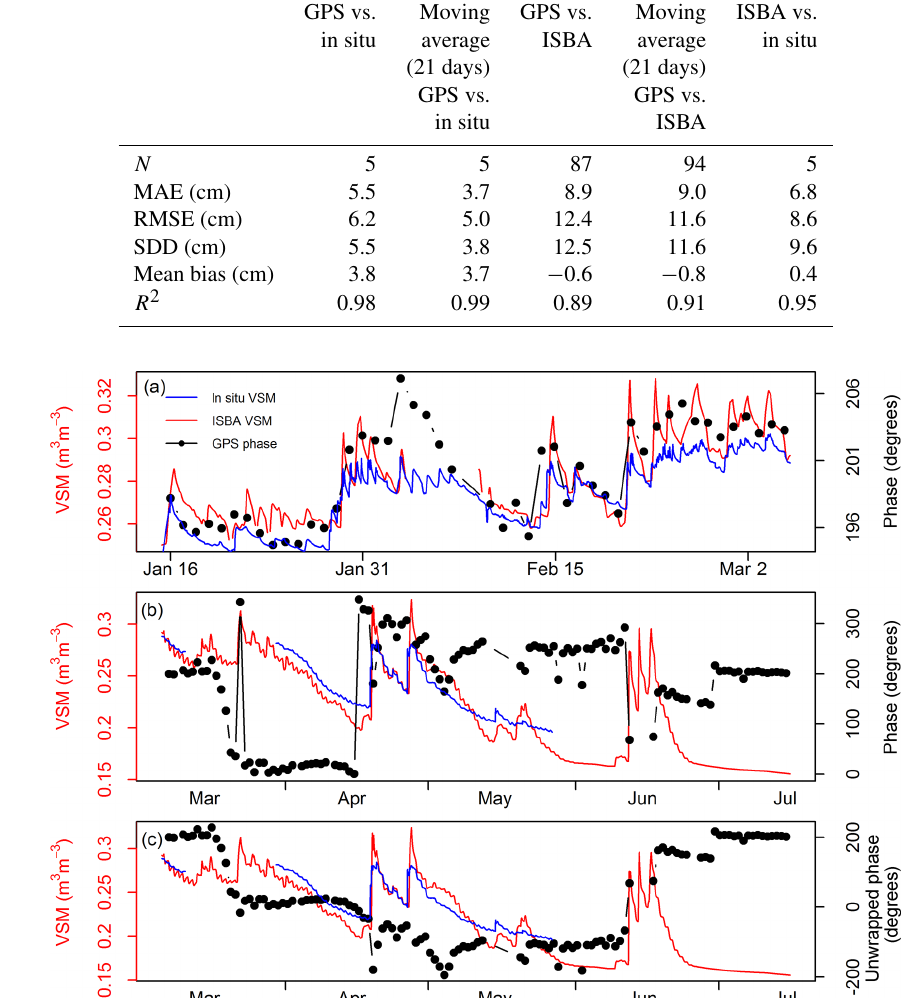
Table 4. Vegetation height scores from 10 March to 11 June 2015. MAE is the mean absolute error, RMSE is the root mean square error and SDD is the standard deviation of differences GPS vs.